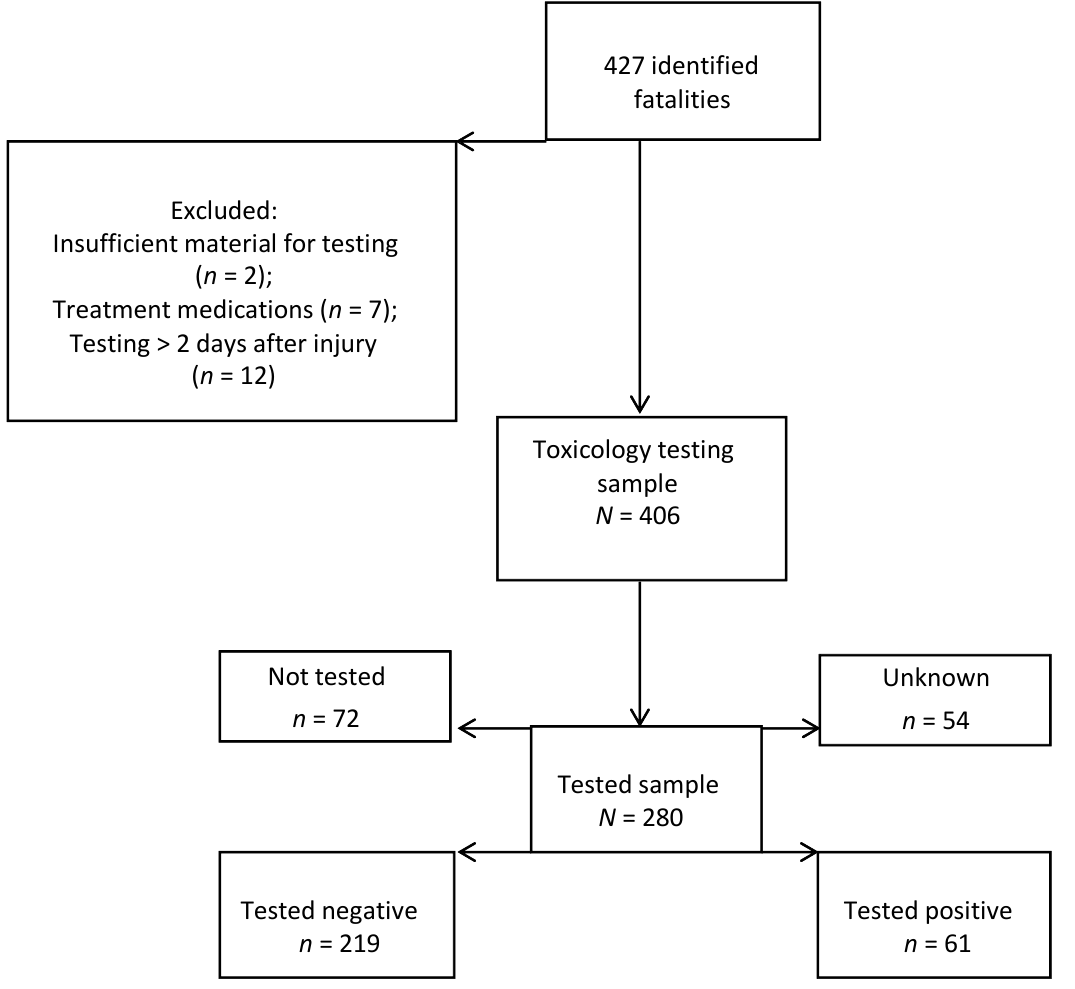
Figure 1. Iowa FACE cases: Flow chart showing inclusions and